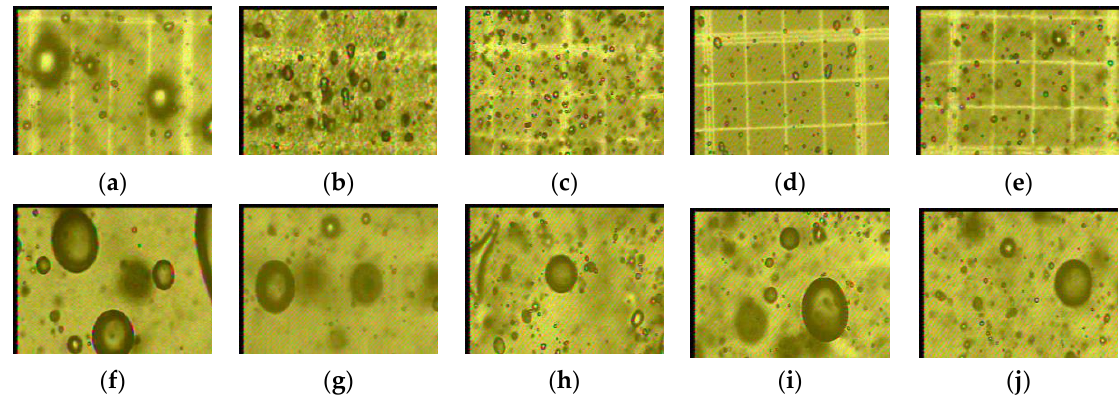
Figure 4. Creams observed with a 40× objective lens on day 0: ( a ) Blank cream; ( b ) cream with AG; ( c ) cream with TG; ( d ) cream with CG; ( e ) cream with PG. Creams observed with a 40× objective lens on day 21 at 4 °C: ( f ) Blank cream; ( g ) cream with AG; ( h ) cream with TG; ( i ) GC cream; ( j ) cream with PG.